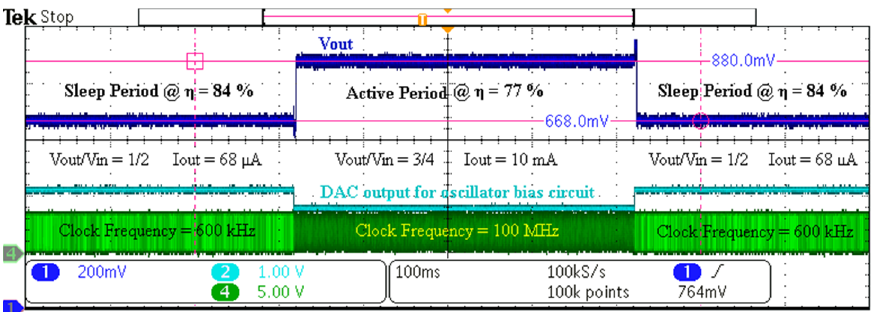
Figure 11. Measurement results demonstrating wide load range performance over various switching frequencies for a voltage conversion ratio of 3 / 4.